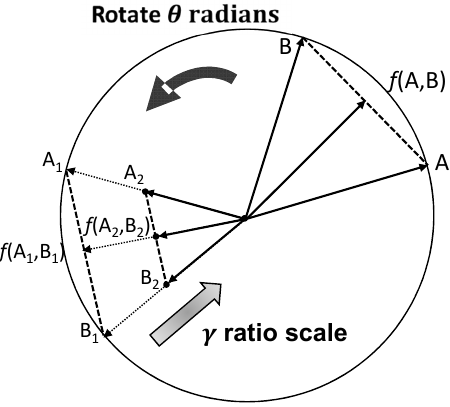
Figure 1. Homogeneity = Rotational invariance + Ratio scale